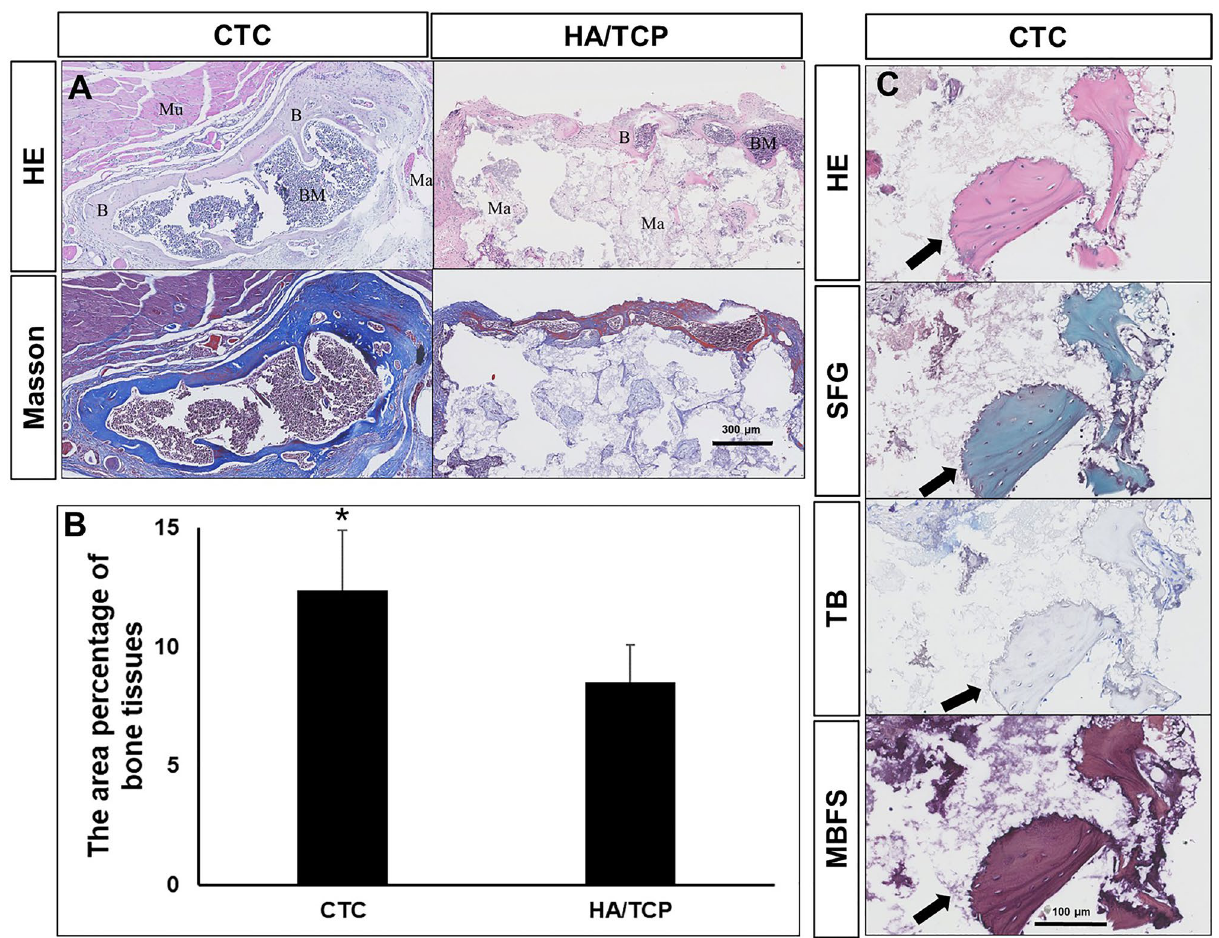
Figure 6. The microstructure of implanted materials and the area percentage of new bone tissues. ( A ) HE and Masson’s trichrome staining photos showed the microscopic details of samples. In HE photos, the bone tissues were stained pink, and bone marrow cells were dark blue. In Masson’s trichrome staining, the collagen fibers were stained blue, while the mature bone tissues were stained red. B bone tissues, BM bone marrow, Mu muscle, Ma materials, Bar: 300 μm. ( B ) The area percentage of new bone tissues was (12.38 ± 2.52) % in the CTC group, and (8.52 ± 1.57) % in the HA/TCP group, * P < 0.05. ( C ) The serial sections of hematoxylin–eosin (HE), sarranine-fast green (SFG), toluidine blue (TB) and methylene blue-basic fuchsin solution (MBFS) staining showing only bone tissue, no cartilage was observed during the osteoinduction. Arrow: bone tissues; bar: 100